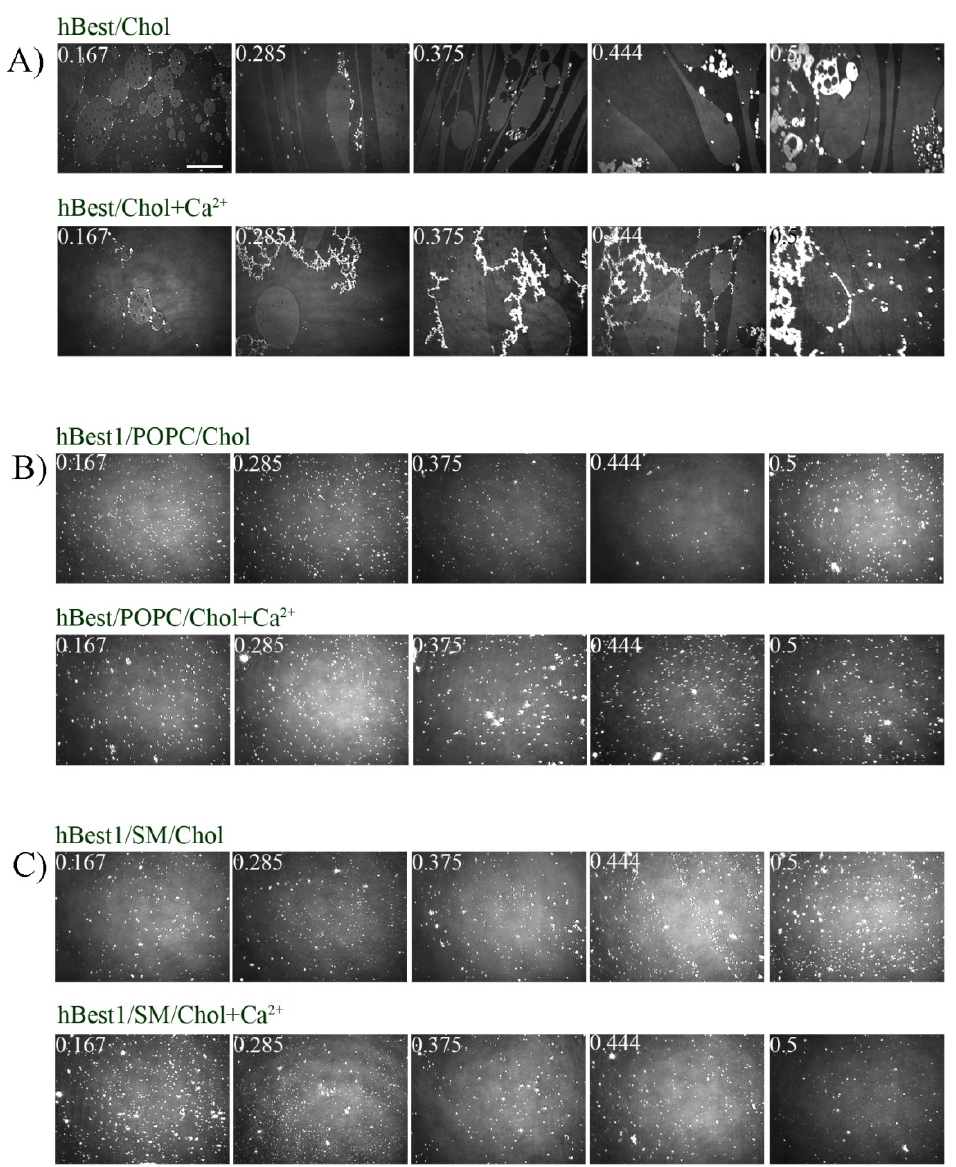
Figure 2. BAM images of ( A ) hBest1/Chol monolayers, ( B ) hBest1/POPC/Chol, and ( C ) hBest1/SM/Chol monolayers (at molar fractions of Chol 0.167; 0.285; 0.375; 0.444 and 0.5) in the presence or absence of Ca 2+ , at 35 ± 2 °C. The white scale bar = 100 μ m.